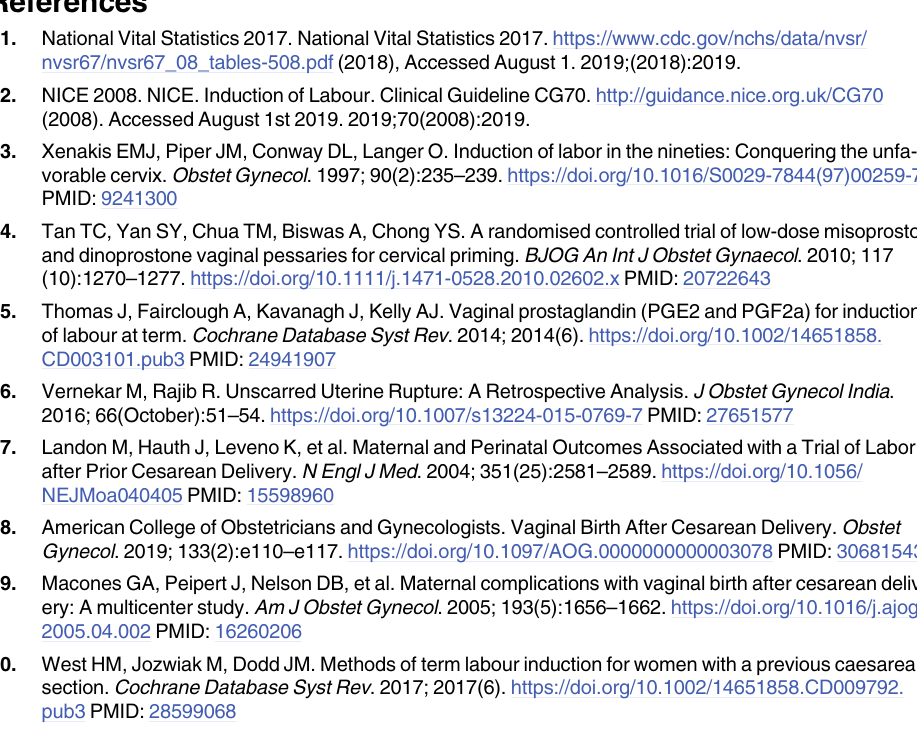
S1 Table. Electronic search. S2 Table. Characteristics of the included